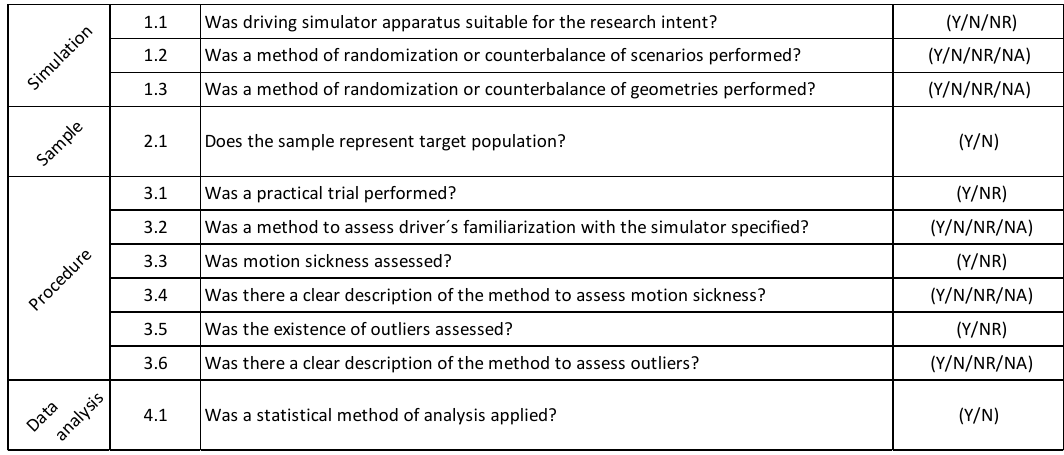
Table 1 . Quality assessment questions and possible